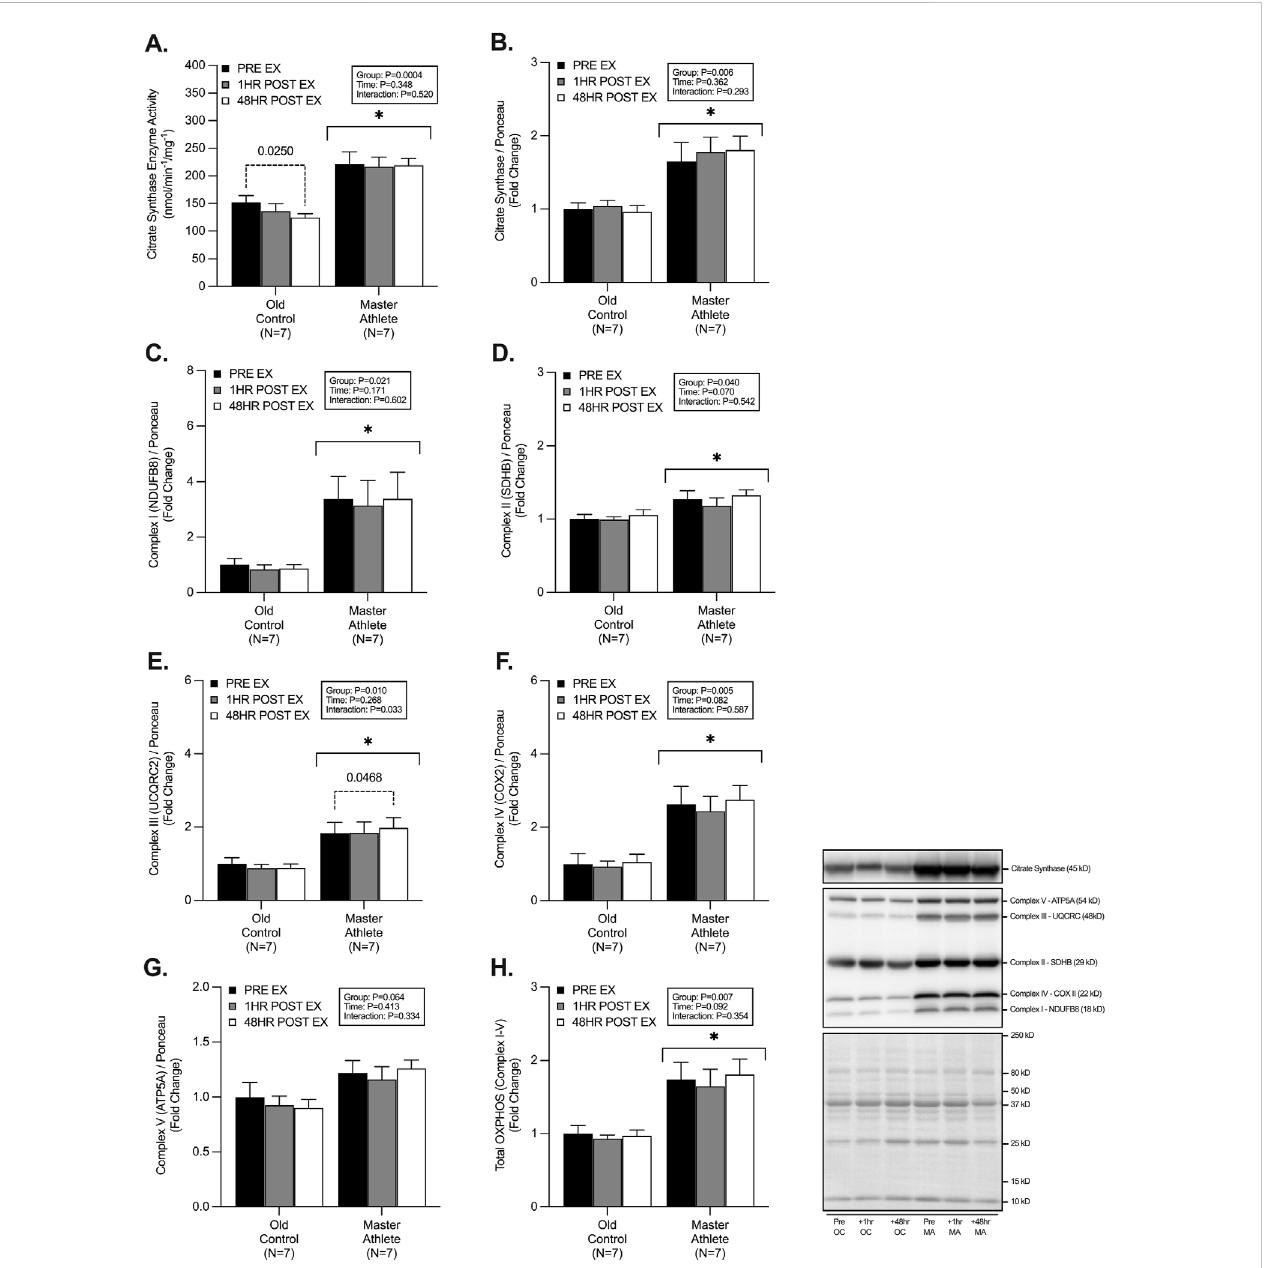
FIGURE 1 Masterathletes displaygreatercitratesynthase enzymeactivityandmitochondrialcontent comparedwitholdcontrols.Citratesynthaseenzymeactivity (A) citrate synthase protein expression (B) and protein expression of electron transport chain complexes I-V; NDUFB8 (C) , SDHB (D) , UQCRC (E) , COX II (F) , ATP5A (G) , Total OXPHOS (H) at rest (Black), 1 h post-resistance exercise (Grey), and 48 h post-resistance exercise (White) in older untrained controls (N = 7) and master athletes (N = 7). All proteins are expressed relative to the total protein stain (Ponceau S). Signi fi cance was set at p < .05. The symbol “ p ” with solid black bars indicates signi fi cantly different from older untrained control ( p < .05). The p -value with dotted lines indicates signi fi cantly different from pre- exercise rest ( p < .05). Values are presented as fold-change relative to pre-exercise old